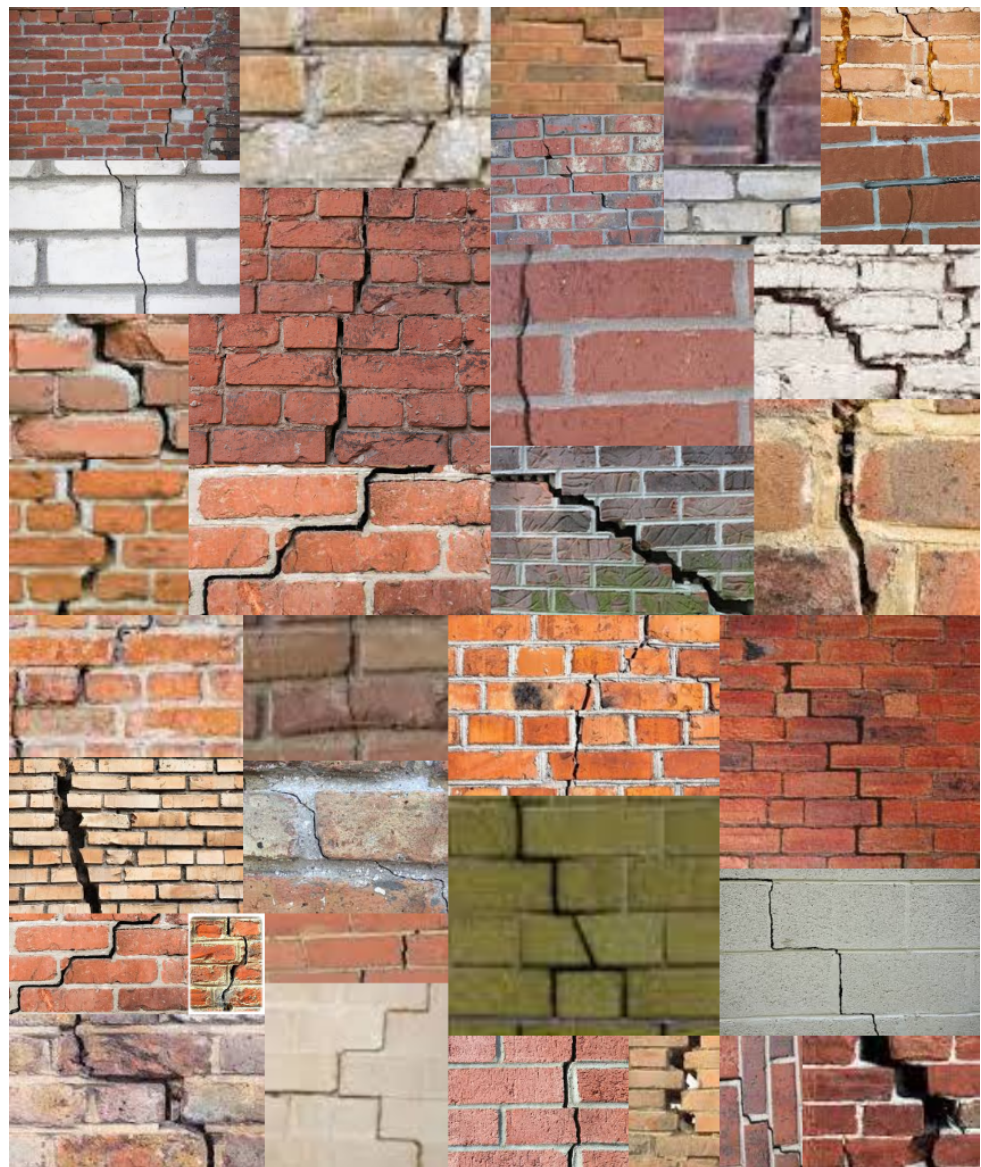
Figure 2. Illustration of some images found on Google which were labeled